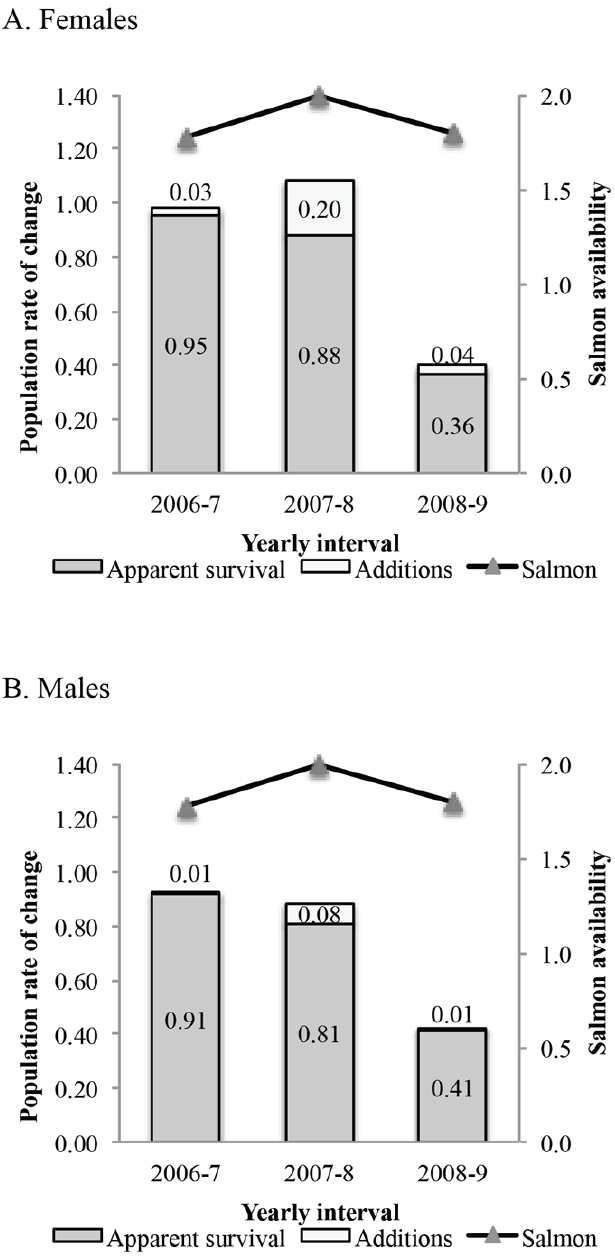
Fig. 3 . Model averaged estimates of rates of addition of new grizzly bears ( Ursus arctos horribilis ) shown with estimates of salmon availability for female (A.) and male (B.) bears in the Koeye River study area